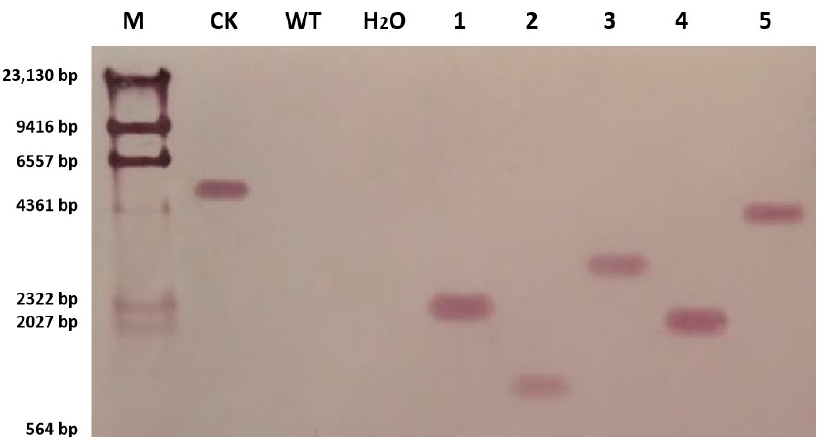
Figure 7. Southern blotting hybridization of T3 generation of transgenic Arabidopsis thaliana with GmPLMT . M, DIG-labeled λ HindIII DNA markers; CK, positive control; WT and H 2 O, negative controls, lanes 1–5, five random transgenic plants of A. thaliana with GmPLMT .